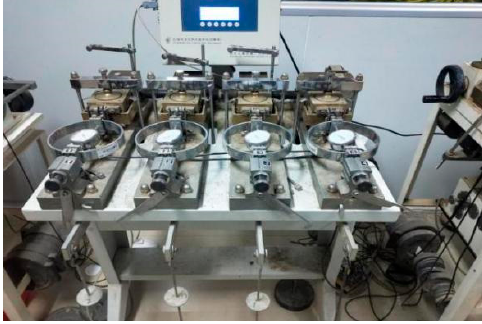
Figure 8. Quadruple strain control direct shear apparatus.